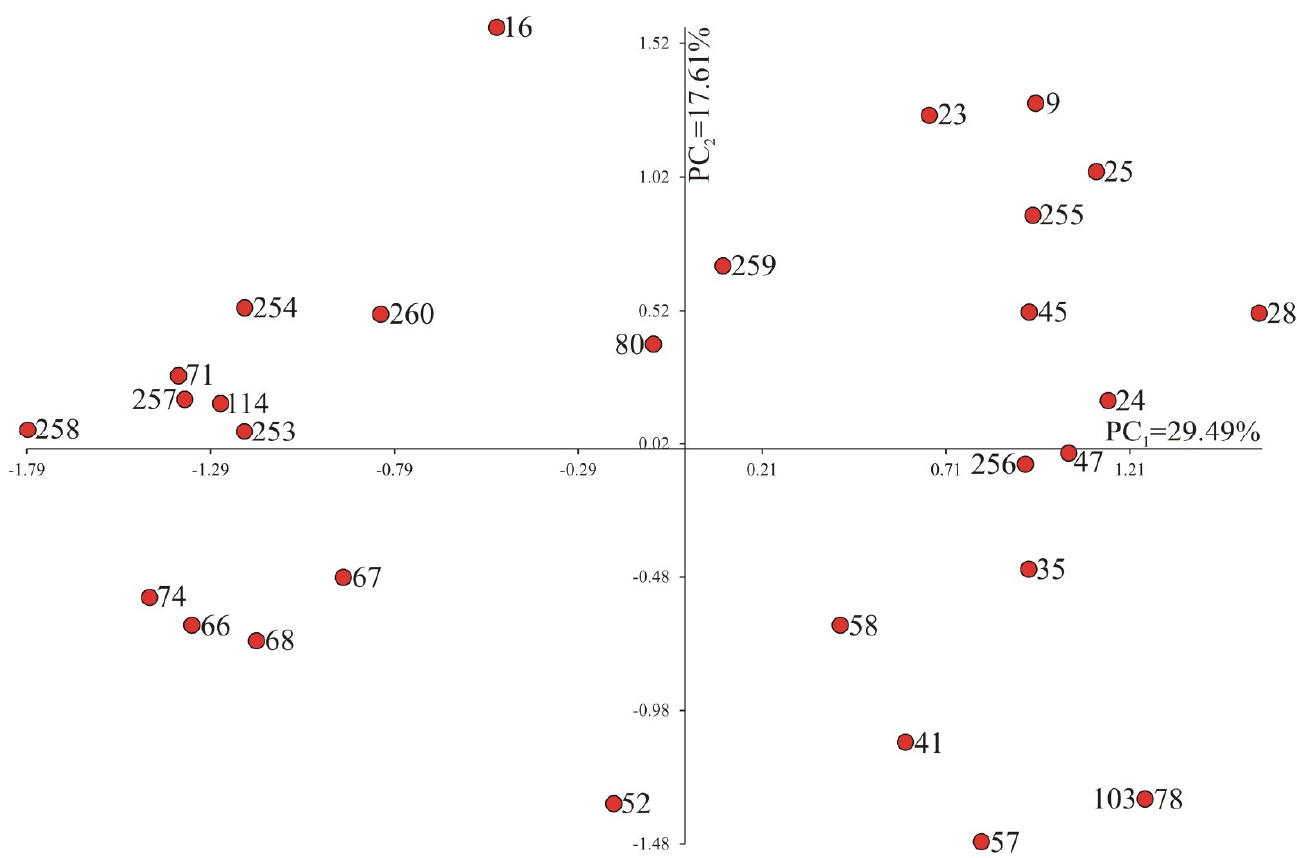
Figure 6. Distribution of 30 maize lines in the space of the first two principal components.